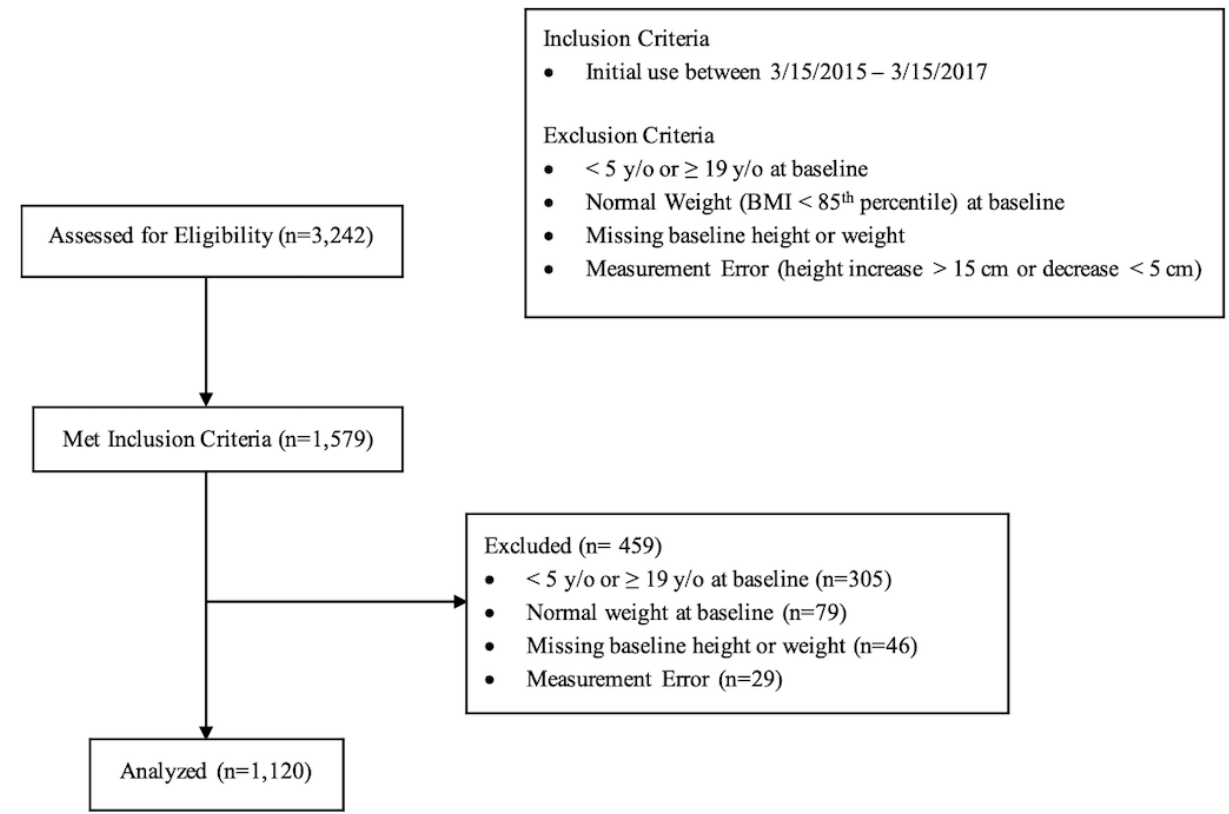
Figure 2. Cohort flow